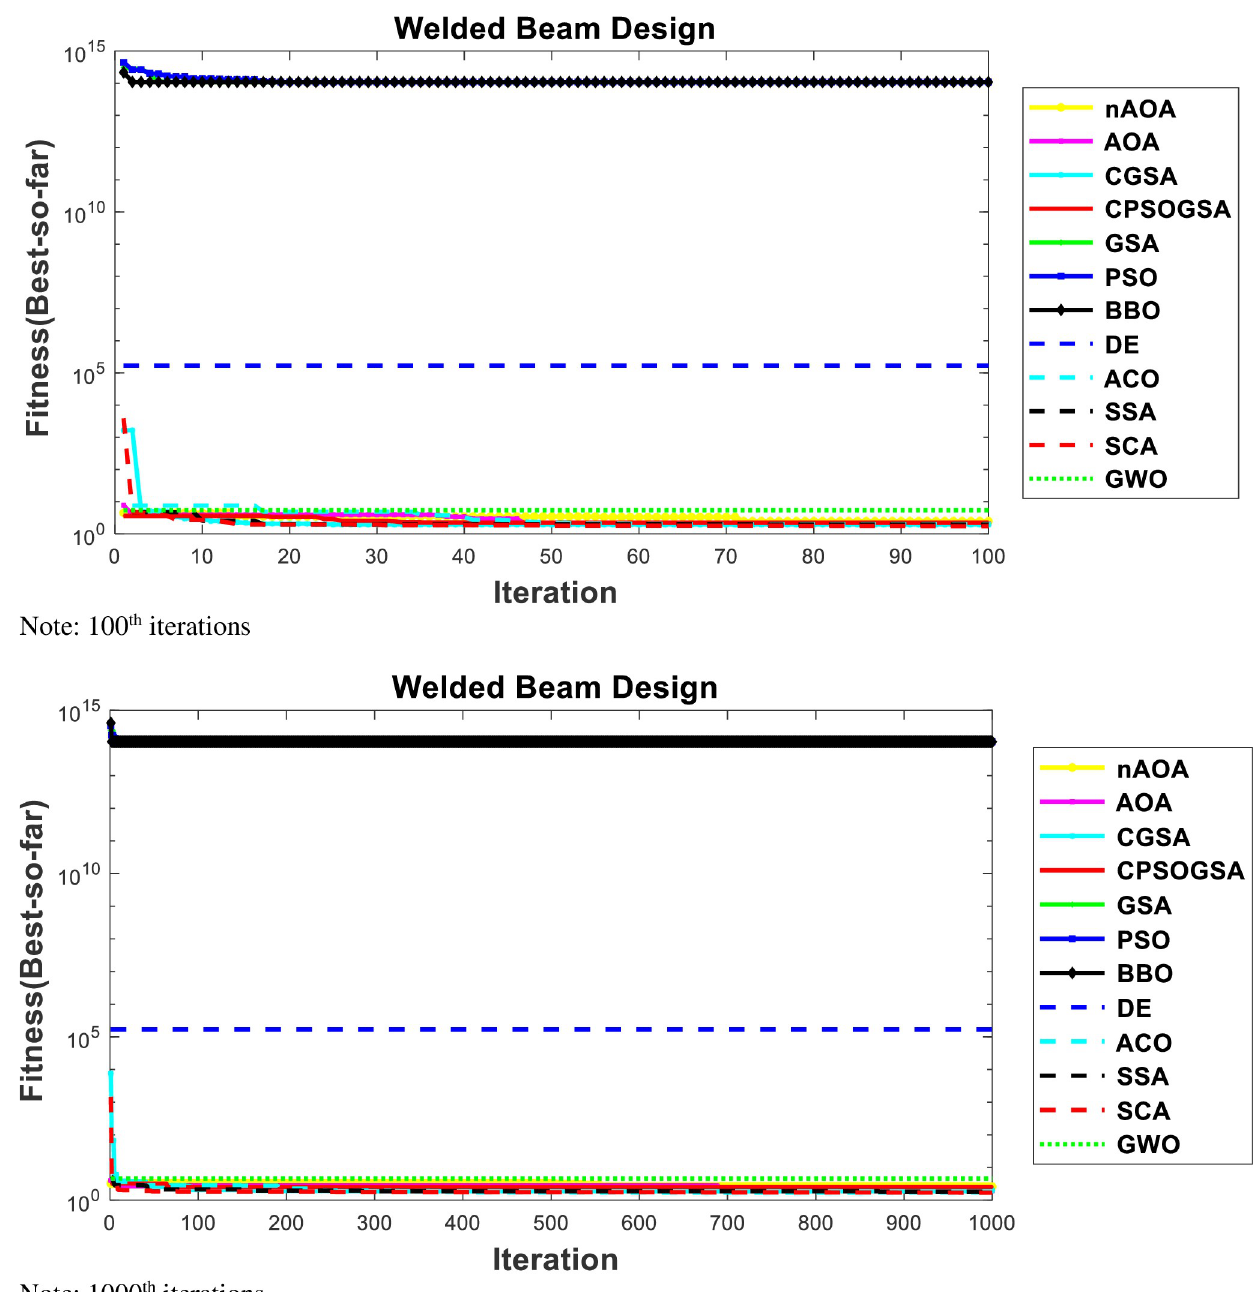
Fig 7. Convergence curves for WBD. Note: 100 th iterations. Note: 1000 th iterations.